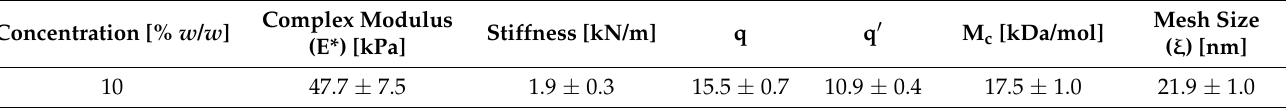
Table 2. Physical Characteristics of 6.0 kDa PEGDA-Based Hydrogels.